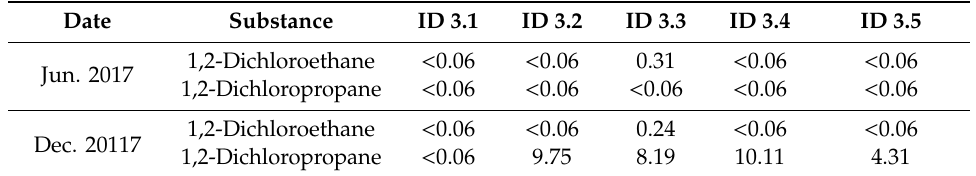
Table 5. Halocarbon concentrations in landfill gas in lot 3 in June and December 2017. IDs refer to di ff erent sampling points (Figure 5). Values in mg / m 3 .